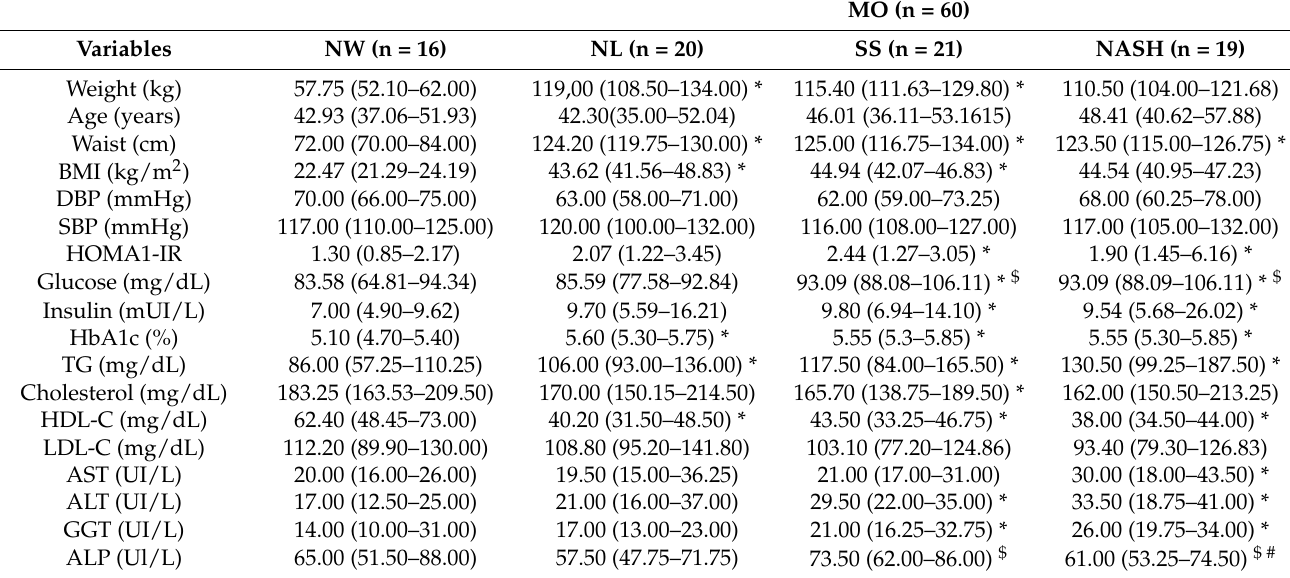
Table 1. Biochemical and anthropometric variables of patients of the